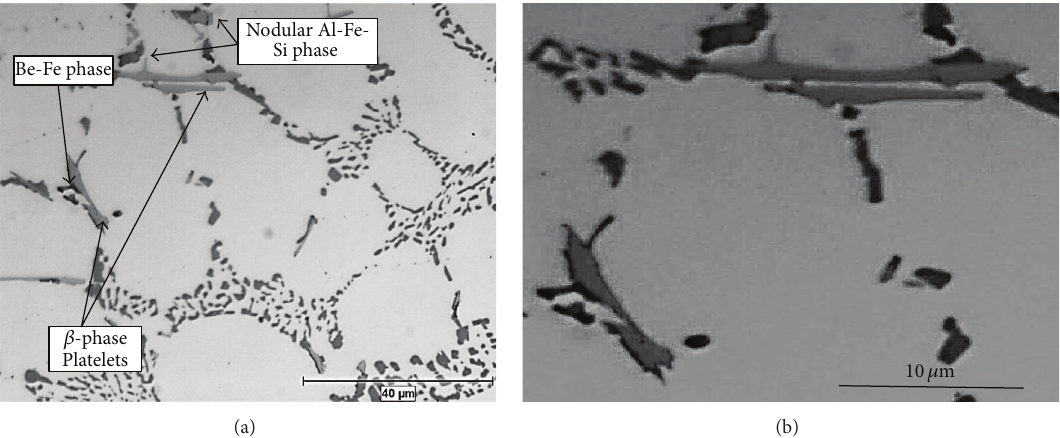
Figure6:OpticalmicrostructuresofSr-modifiedC3BSalloyshowing(a)nodularandplateletformsofAl 5 FeSi, 𝛽 -phase,and 𝜋 -phaseparticles and possibly Be-Fe containing phase particles. (b) Enlarged portion of (a) revealing the irregular shape of the 𝛽 -Al 5 FeSi platelets.